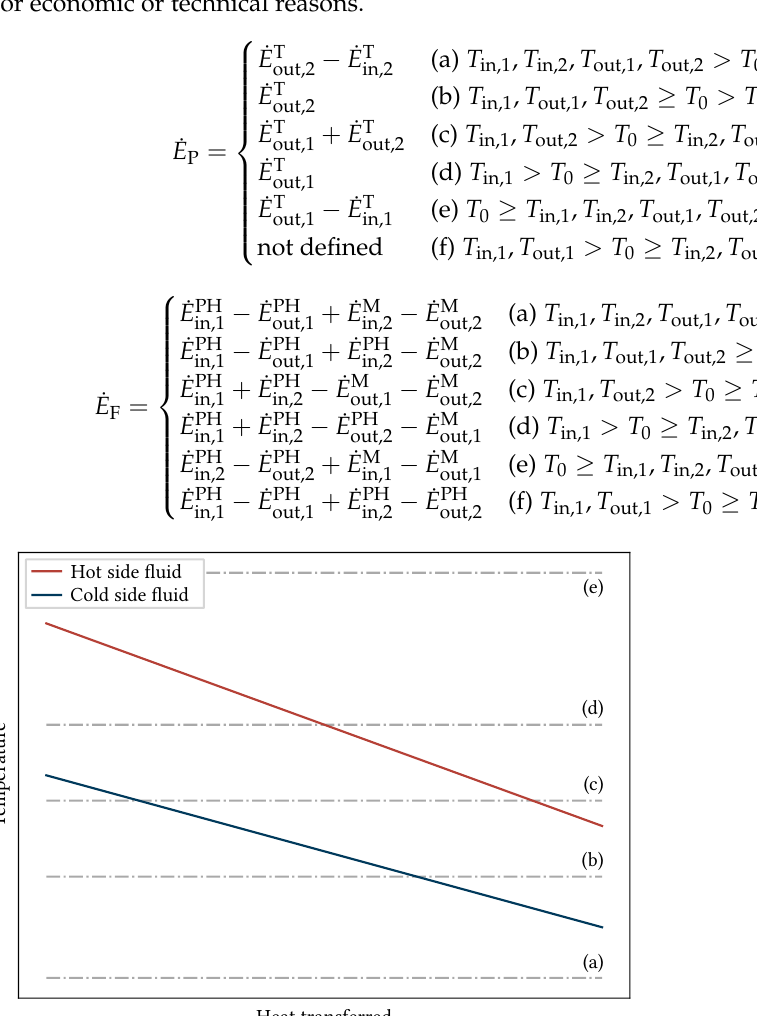
Figure 2. Illustration of use cases for heat exchangers. Not illustrated: variant